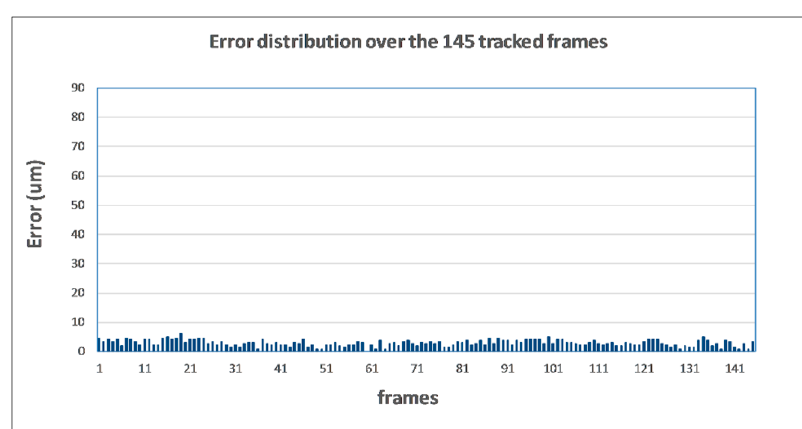
Figure 17. Error distribution over the 145 tracked frames.